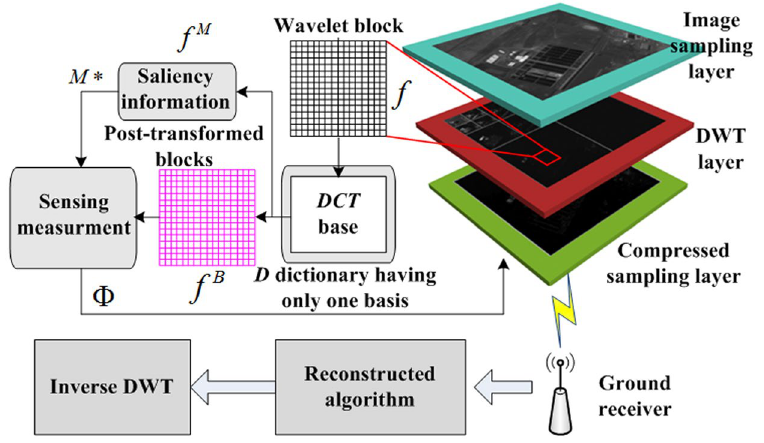
Figure 7. Principle of S-CS based on post-wavelet